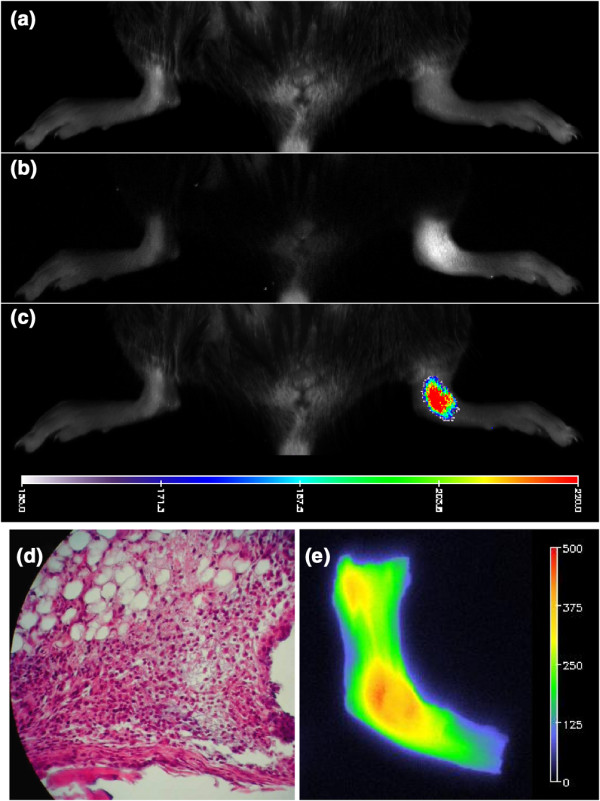
In vivo near-infrared fluorescent (NIRF) imaging of inflammatory joints in the lipopolysaccharide (LPS) induction model. The NIR2-folate probe was intravenously injected 2 days after LPS intra-articular injection. (a) White-light images obtained 48 hours after intra-articular LPS injection at the right ankle joint; soft tissue swelling was noted at the affected joint. (b) NIRF images obtained 24 hours after NIR2-folate injection. Note the strong fluorescence signal in the LPS-treated ankle compared with the opposite control side (enhancement ratio = 2.31). (c) A merged NIRF signal with a white-light image showing specific increased fluorescence signal intensity at the affected joint. (d) H&E-stain section of the right ankle joint showing abundant inflammatory cell infiltration at subsynovial tissues. Original magnification, 100 ×. (e) NIRF images of a longitudinal section of the LPS-treated ankles. Pseudo-color coding was used to demonstrate the stronger fluorescence signal surrounding the ankle joint.